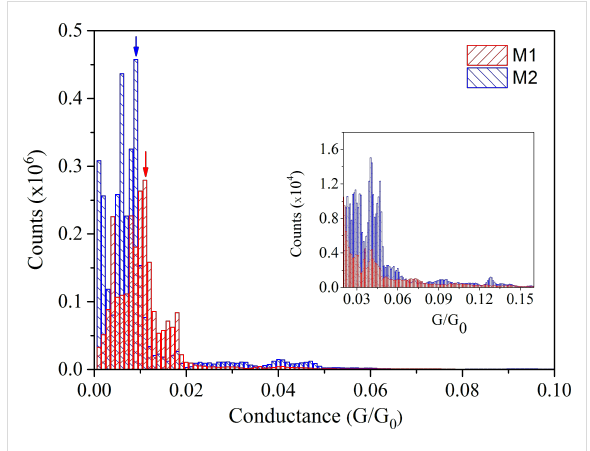
Figure 4: Conductance histograms determined for molecules M1 and M2 at +1 mV during opening and closing cycles of the break junction. Inset: Enlarged conductance regime above 0.02G 0 .